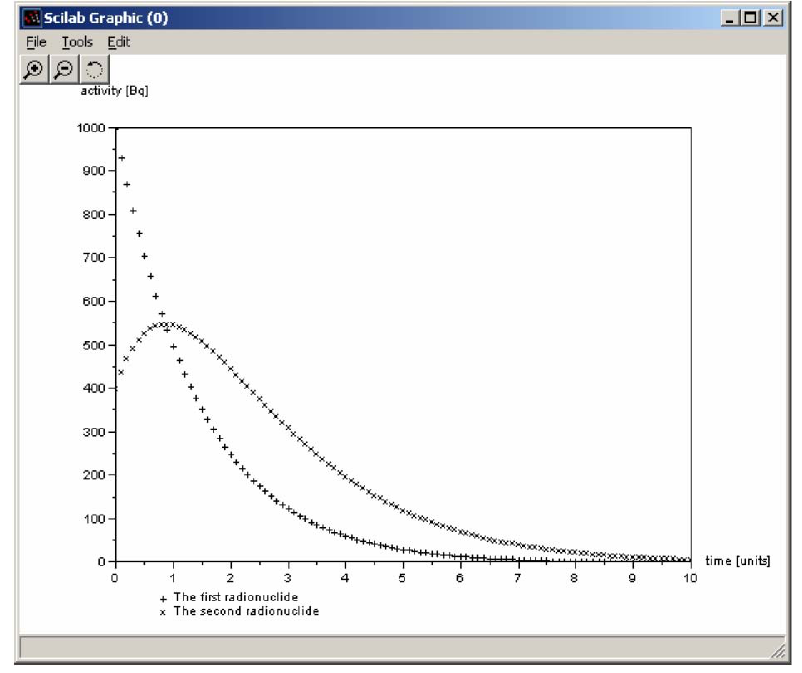
Fig. 1 Time dependence of the activity of two genetically coupled radionuclides calculated by the elaborated